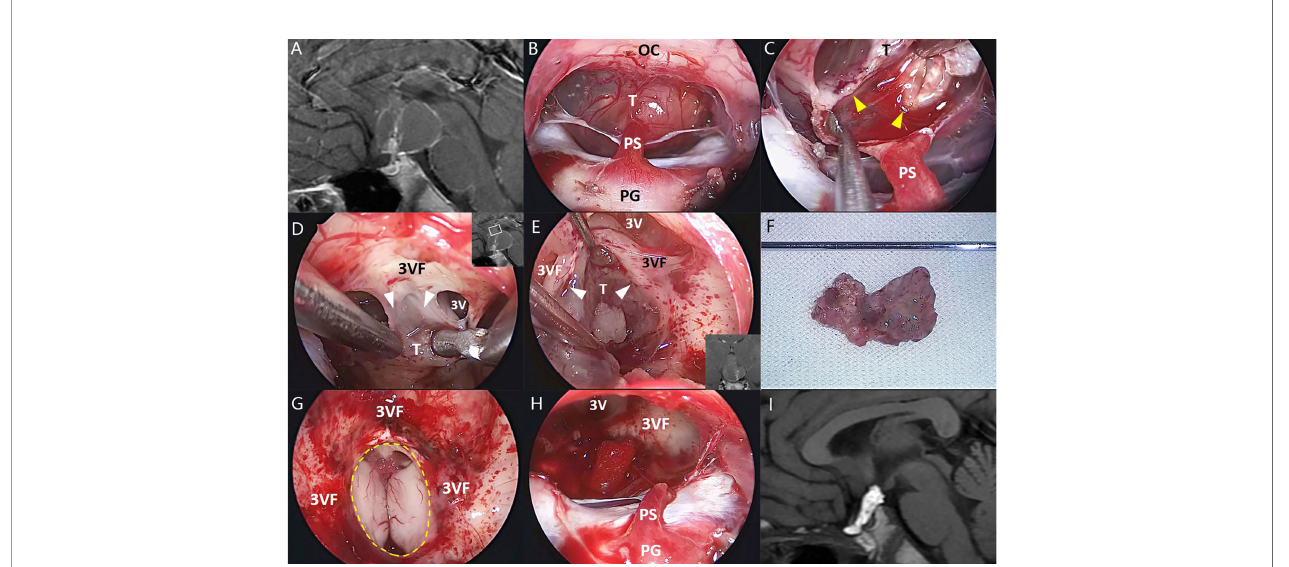
FIGURE 3 | Illustrative endonasal case 3 clarifying the tumor – ventricle relationship. In (A) , preoperative MRI shows a tumor with predominantly ventricular development above the pituitary stalk. In (B) , intraoperative photograph indicates the mostly intact pituitary stalk beneath the tumor. In (C) , the surgical dissection was performed along a clear tumor – infundibulum interface (yellow arrowhead). In (D, E) , a non-functional layer of reactive gliosis between the tumor and the third ventricle fl oor without leptomeningeal tissue (white arrowhead) was used in this case as a safe plane of dissection, although it is dif fi cult to remain the integrity of the third ventricle fl oor at some areas associated with extremely stretched thin ventricular fl oor or tight attachment. In (F) , the tumor was removed en bloc after dissection. In (G, H) , a moderate defect of the third ventricle fl oor (dashed line) and the remnants of the stretched pituitary stalk were preserved after tumor removal. In (I) , postoperative MRI demonstrates the total tumor removal, and the hyperintense T1 signal represents the fat used for skull base reconstruction. 3V, the third ventricle; 3VF, the third ventricle fl oor; OS, optic chiasm; PG, pituitary gland; PS, pituitary stalk; T, tumor.